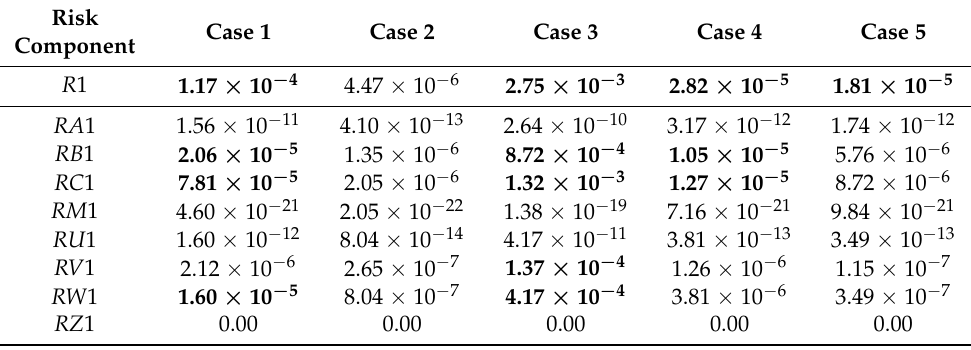
Table 7. Result of Risk Value of Loss of Human Life ( R 1).